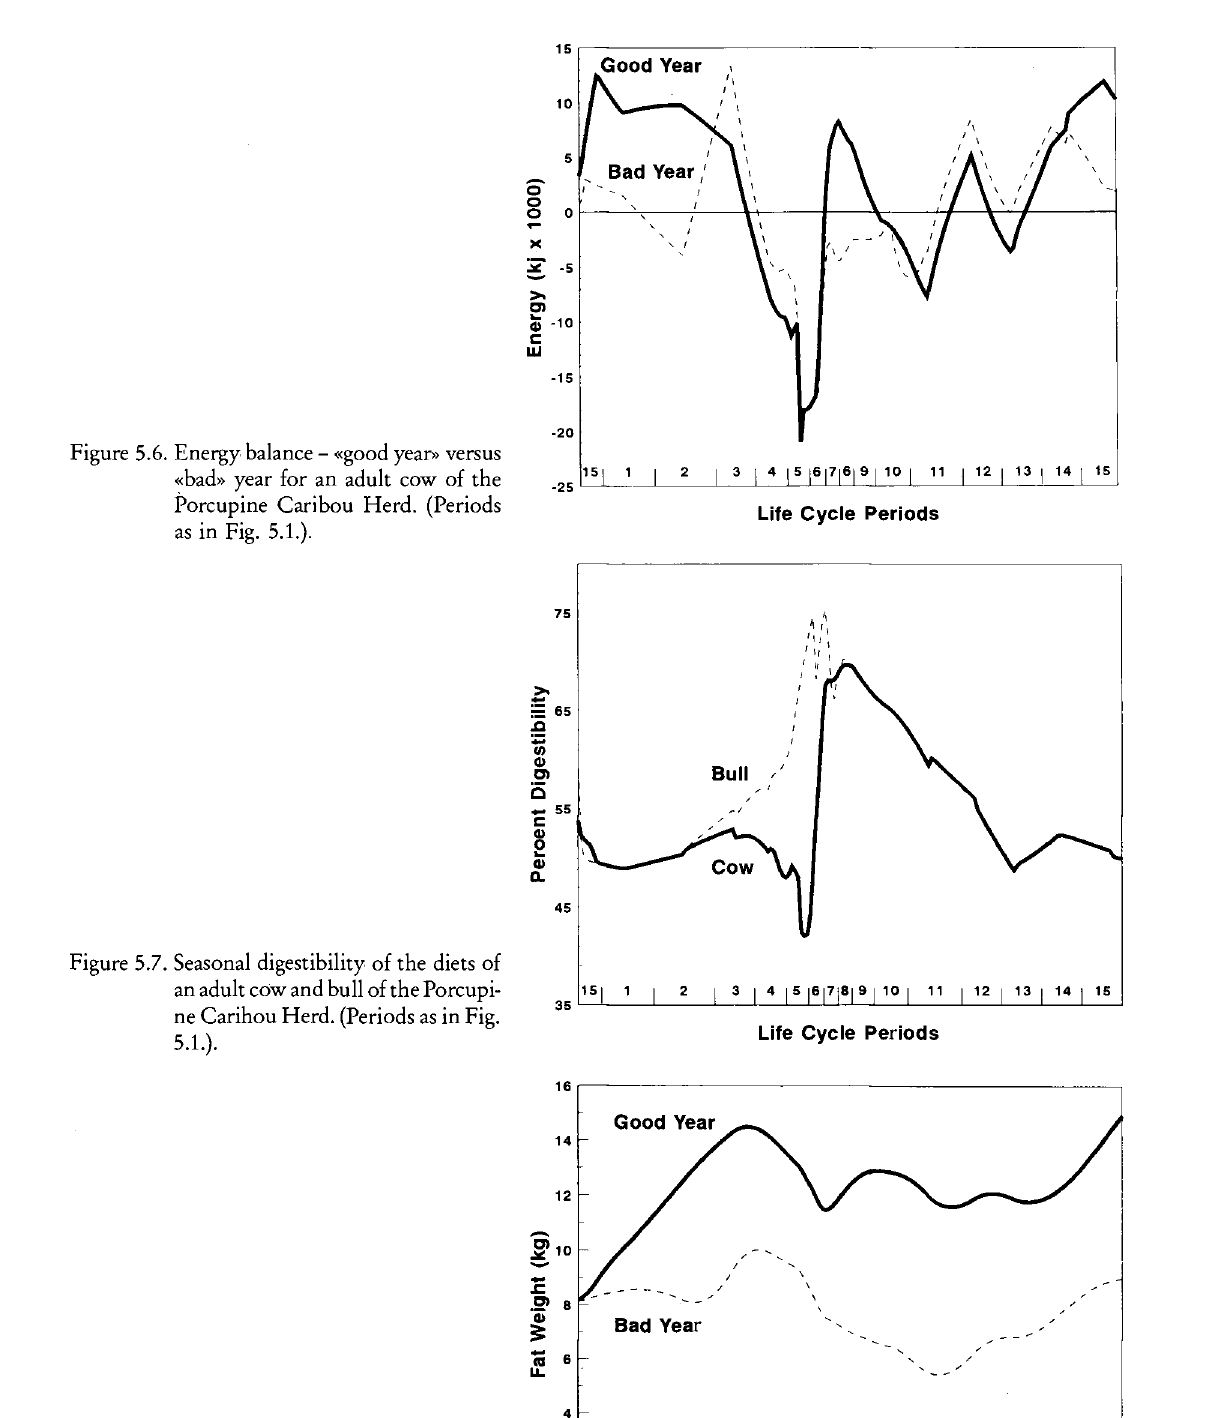
Figure 5.8. Weight of body fat reserves of a fe male Porcupine caribou in a «good» year versus «bad» year. (Periods as in Fig.